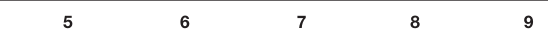
TABLE 4 | Means, standard deviations, and correlations with confidence intervals for measures used in Study 2.